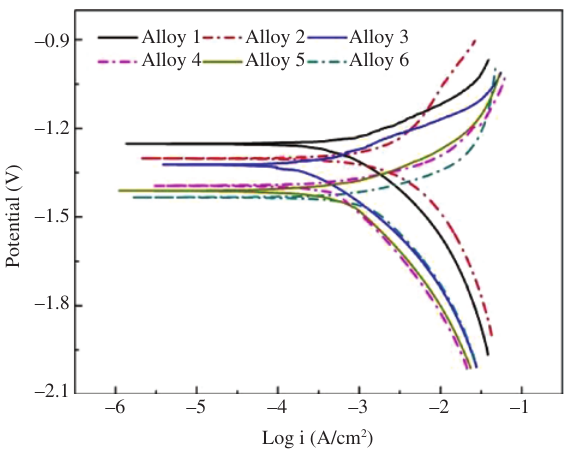
Figure 9: Polarization curves of the investigated degradable com- posites in 3 wt.% KCl at 25 ° C.